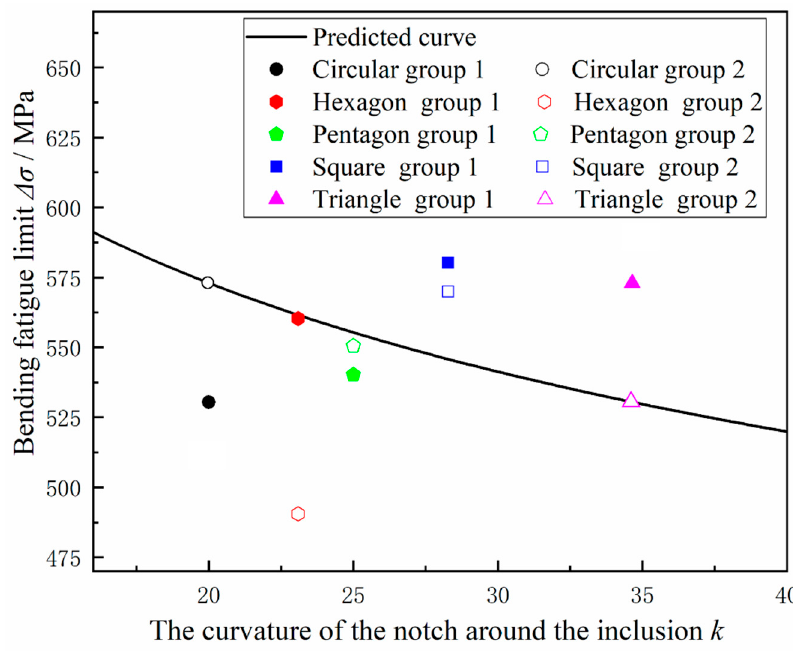
Figure 16. Comparison of the predictions by Equation (6) with the actual experimental fatigue lives.